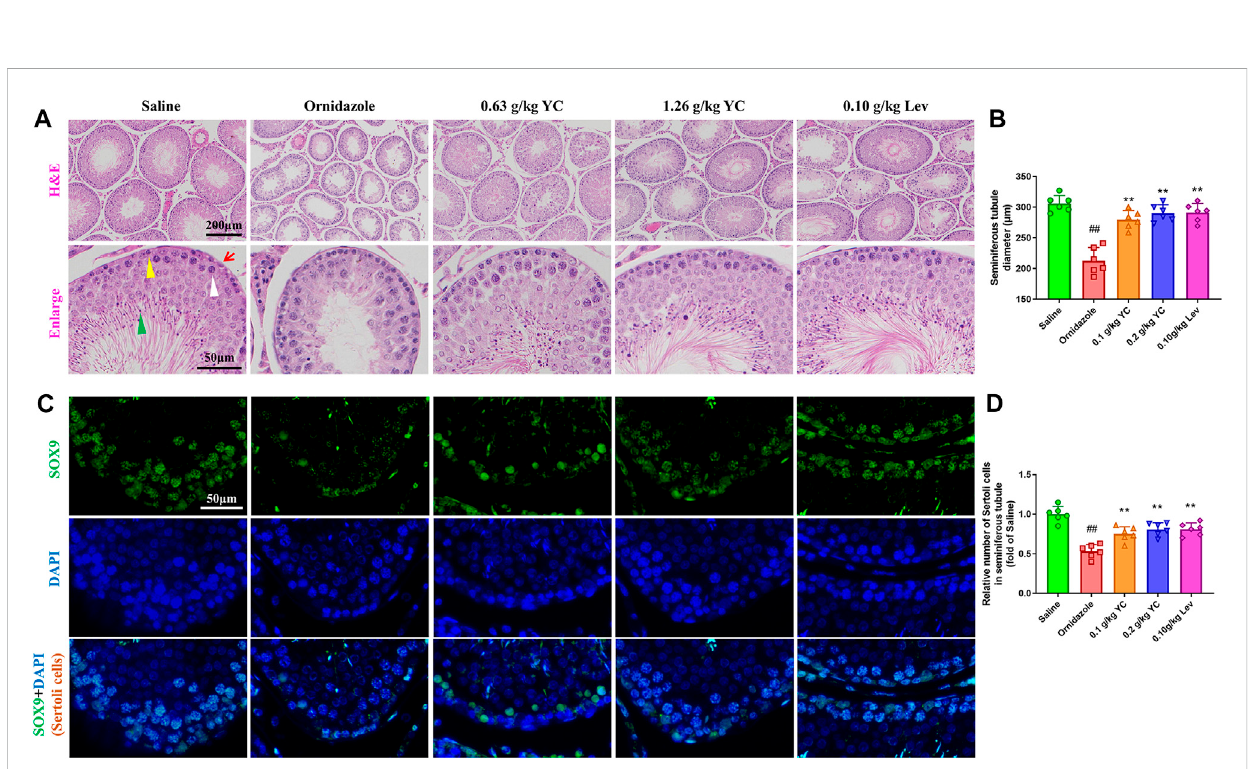
FIGURE 3 Testis features in the H&E staining and immuno fl uorescent analysis. (A) Representative images of hematoxylin-eosin-stained testis sections. Red arrows denote Sertoli cells; yellow triangles denote spermatogonia; white arrows denote primary spermatocytes; and green arrows denote spermatids. (B) Quanti fi cation of the diameters of seminiferous tubules in the H&E staining. (C, D) Representative images and quanti fi cation of SOX9-labelled Sertoli cells in the seminiferous tubule. Values are shown as averages ± SD ( n = 6). ## p < 0.01 versus Saline group; ** p < 0.01 versus Ornidazole